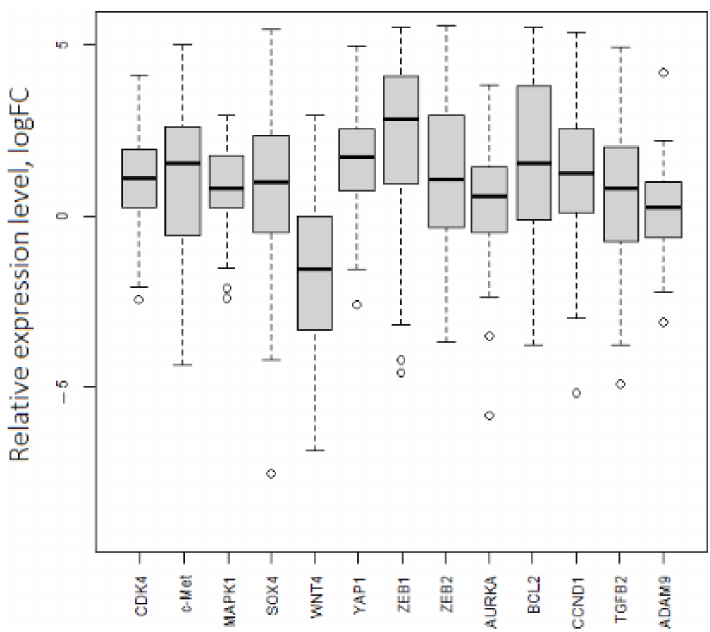
Figure 4. Expression levels of 13 mRNAs in OC. p .adj < 0.05 for each mRNA. Table 2. Spearman’s correlation coefficients between expression levels for different pairs of